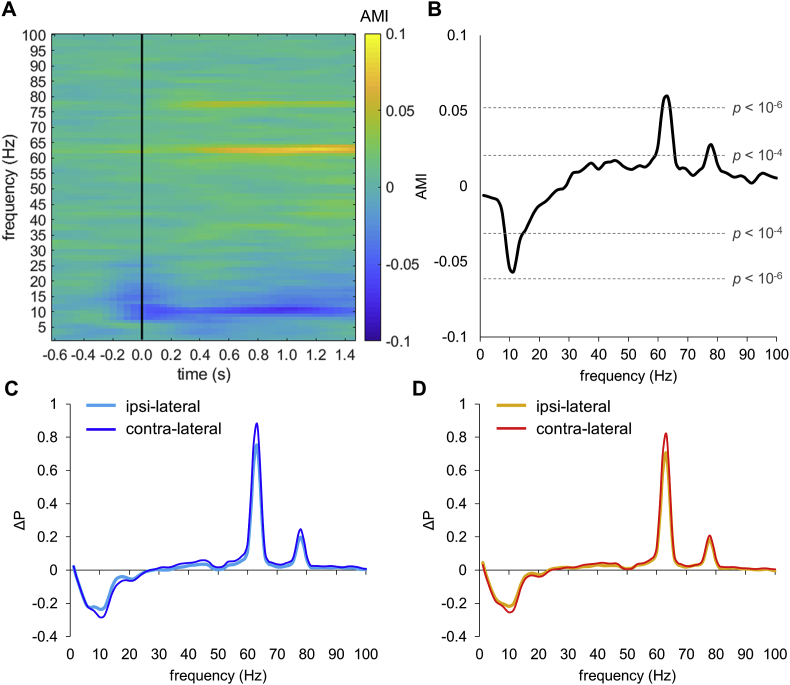
Attention modulates power in the alpha band and at the tagging frequencies. (A) Time-frequency representation of the attention modulation index (AMI). The AMI reflects the power modulation in the sensors contra-versus ipsilateral to the attended hemifield for combined left and right occipital sensors (see Fig. 2C for sensors selection). The power was calculated per trial and then averaged. Black line indicates onset of the frequency tagged stimuli; the cue onset was at −0.5 s. (B) The AMI (averaged over time bins 0.5–1.5 s) at the group level. Dashed lines indicate p-values of the t-test comparing modulation index against zero (over participants). The effect is highly robust in the 8–12 Hz alpha band and at 63 and 78 Hz even if multiple comparisons over frequencies are considered. (C) Relative power change compared to the baseline (−1, −0.5 s) at the left sensors for trials “attention left” (cyan line; ipsilateral to the cue) and “attention right” (blue line; contralateral to the cue). (D) The same as (C) but for the right sensors for trials “attention right” (orange line; ipsilateral to the cue) and “attention left” (red line; contralateral to the cue).